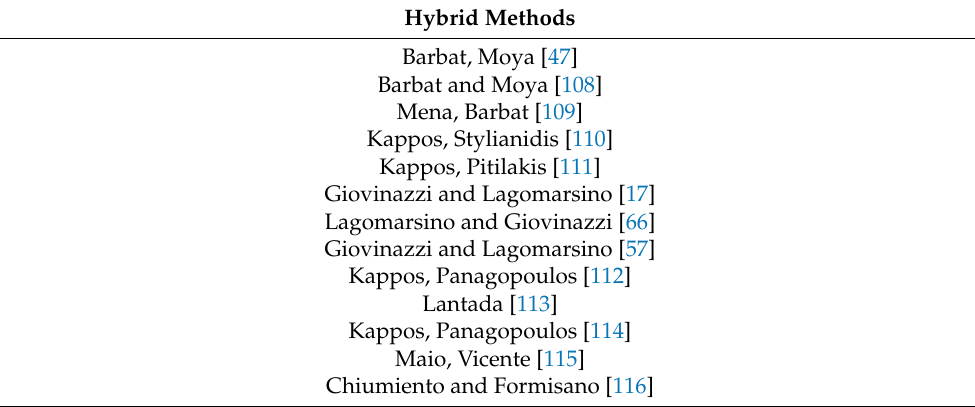
Table 3. Summary of different proposals for the hybrid analysis of masonry